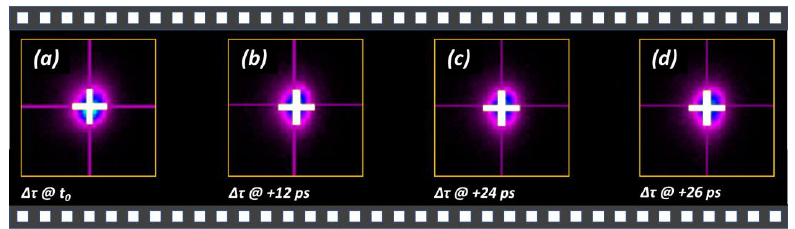
Figure 7. Temporal sequence of the pump focus position at four different delays ( Δτ ), keeping the feedback pointing system activated, specifically at ( a ) t 0 , ( b ) the half range at Δτ = +12 ps, and at end of the mechanical rails ( c ) at Δτ = +24 ps and ( d ) Δτ = +26 ps . The white cross refers to the desired target position. The estimated spot sizes are 10 μm (FWHM).